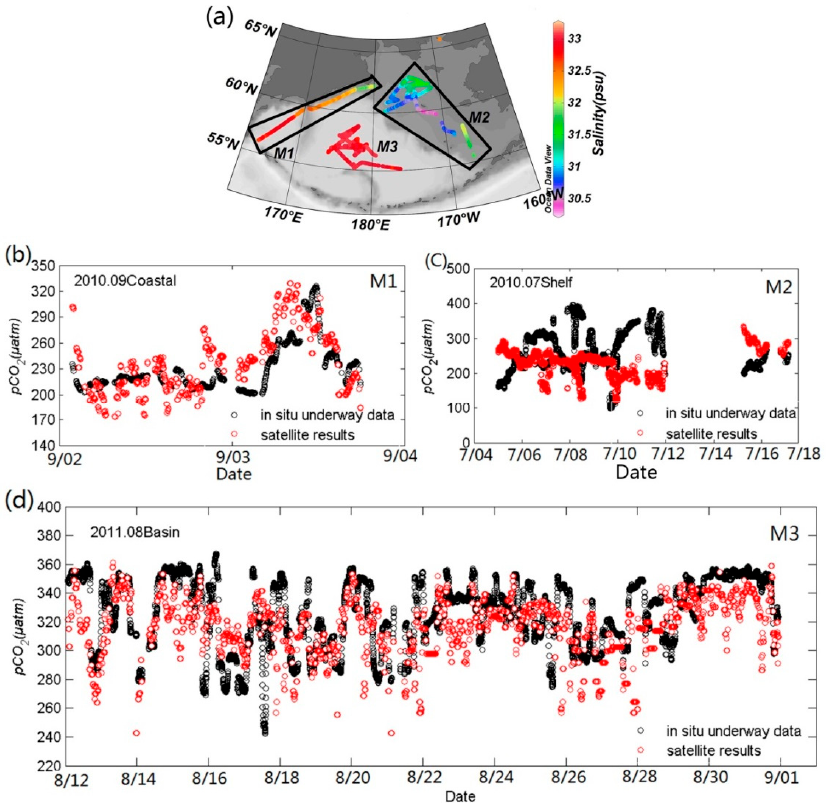
Figure 7. The comparison between monthly satellite-derived p CO 2 with underway data. ( a ) The location of the match-up data in September 2010 (M1), July 2010 (M2), and August 2011 (M3) with the salinity marked; the comparison between satellite-derived p CO 2 and underway p CO 2 data in the western coastal area (M1) ( b ); the shelf (M2) ( c ); and the basin (M3) ( d ).